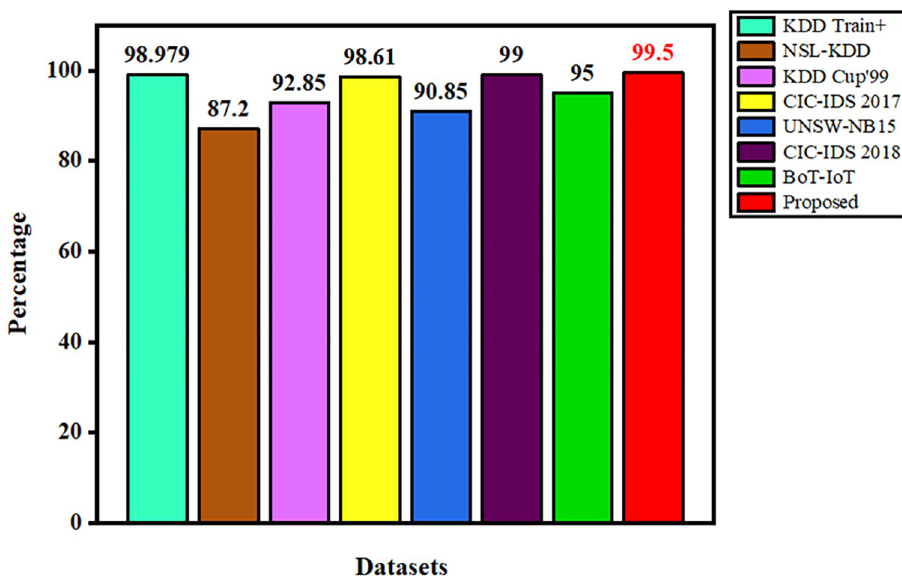
Fig 12. Accuracy comparison with various